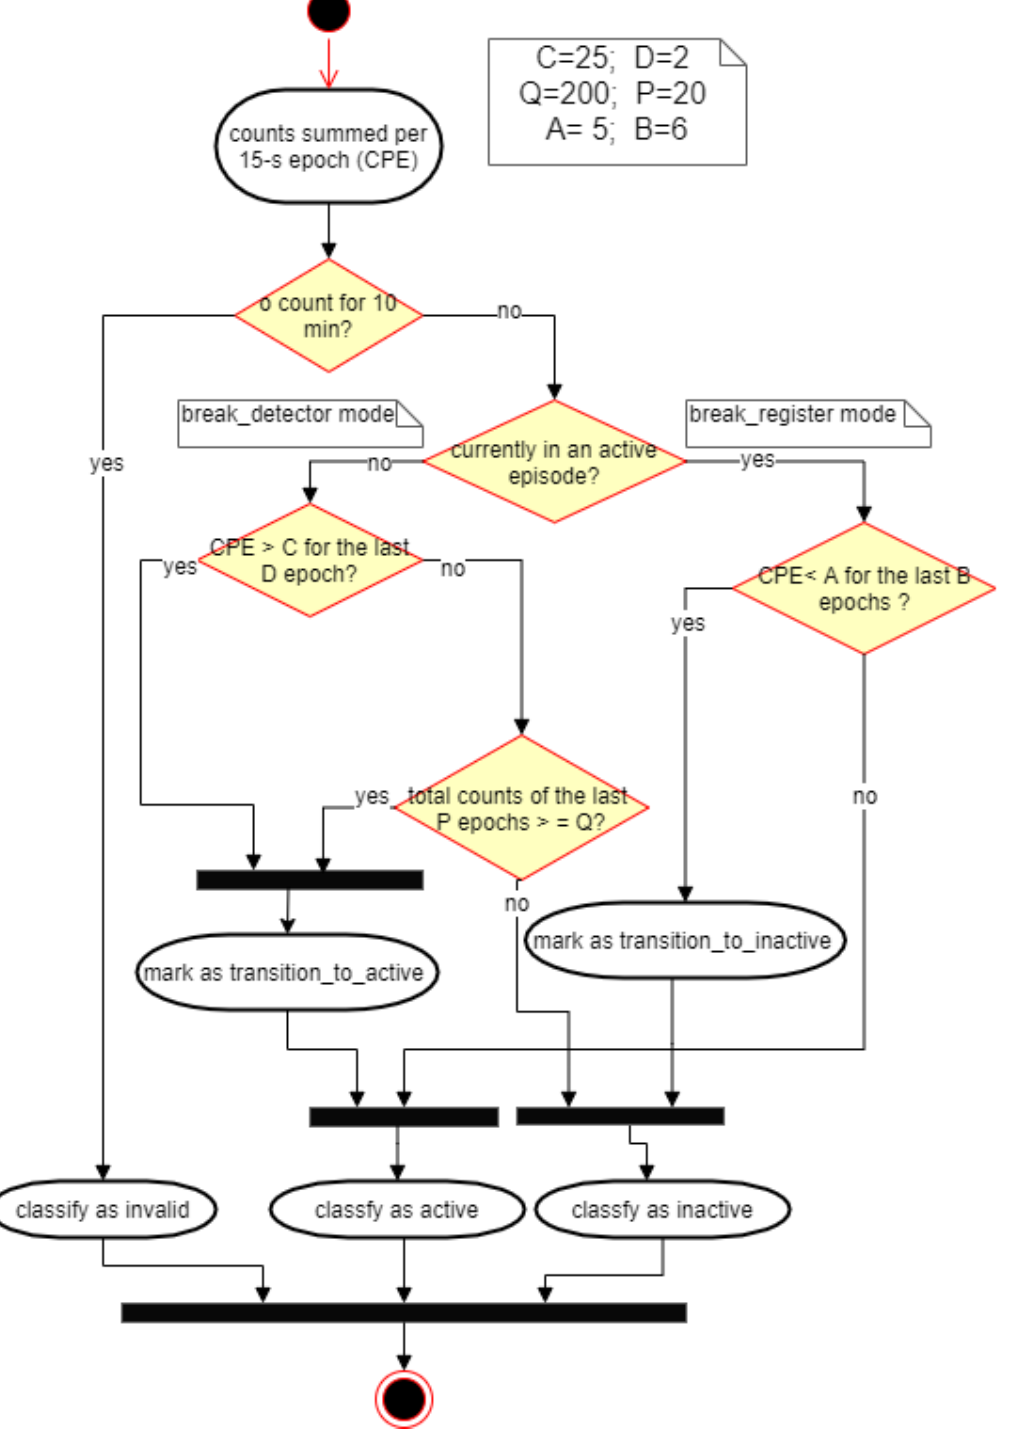
Figure 4. Activity classification